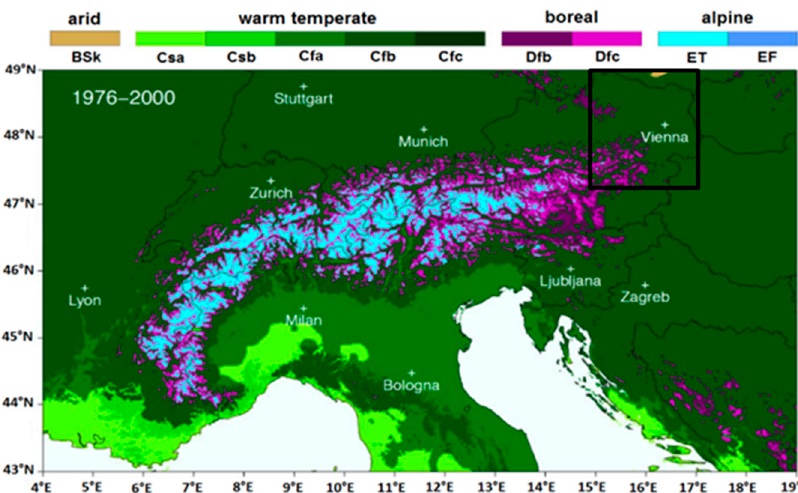
Figure 1. Climate of Austria based on Köppen climate classification—updated by Rubel et al. 2017. The black box indicates the study area.